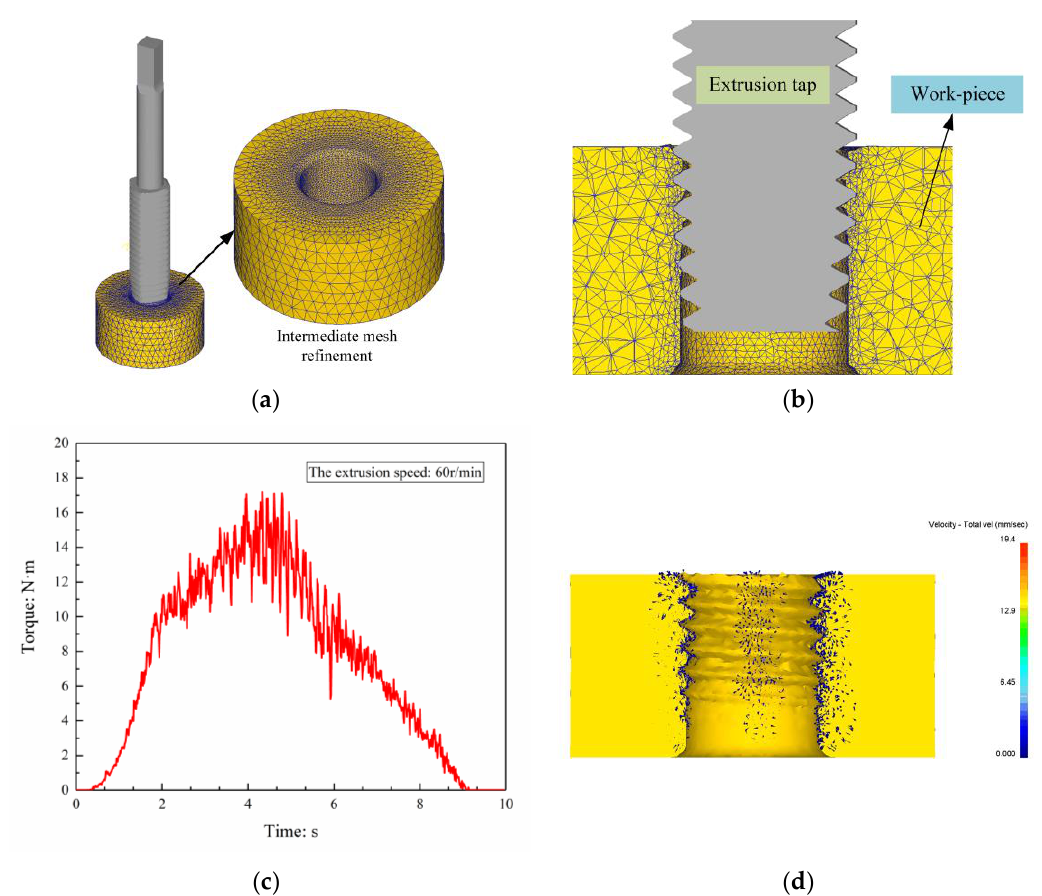
Figure 4. Simulation results of internal thread extrusion ( a ) FEM, ( b ) Extrusion process model, ( c ) Torque change curve during extrusion, ( d ) Metal flow direction during extrusion.